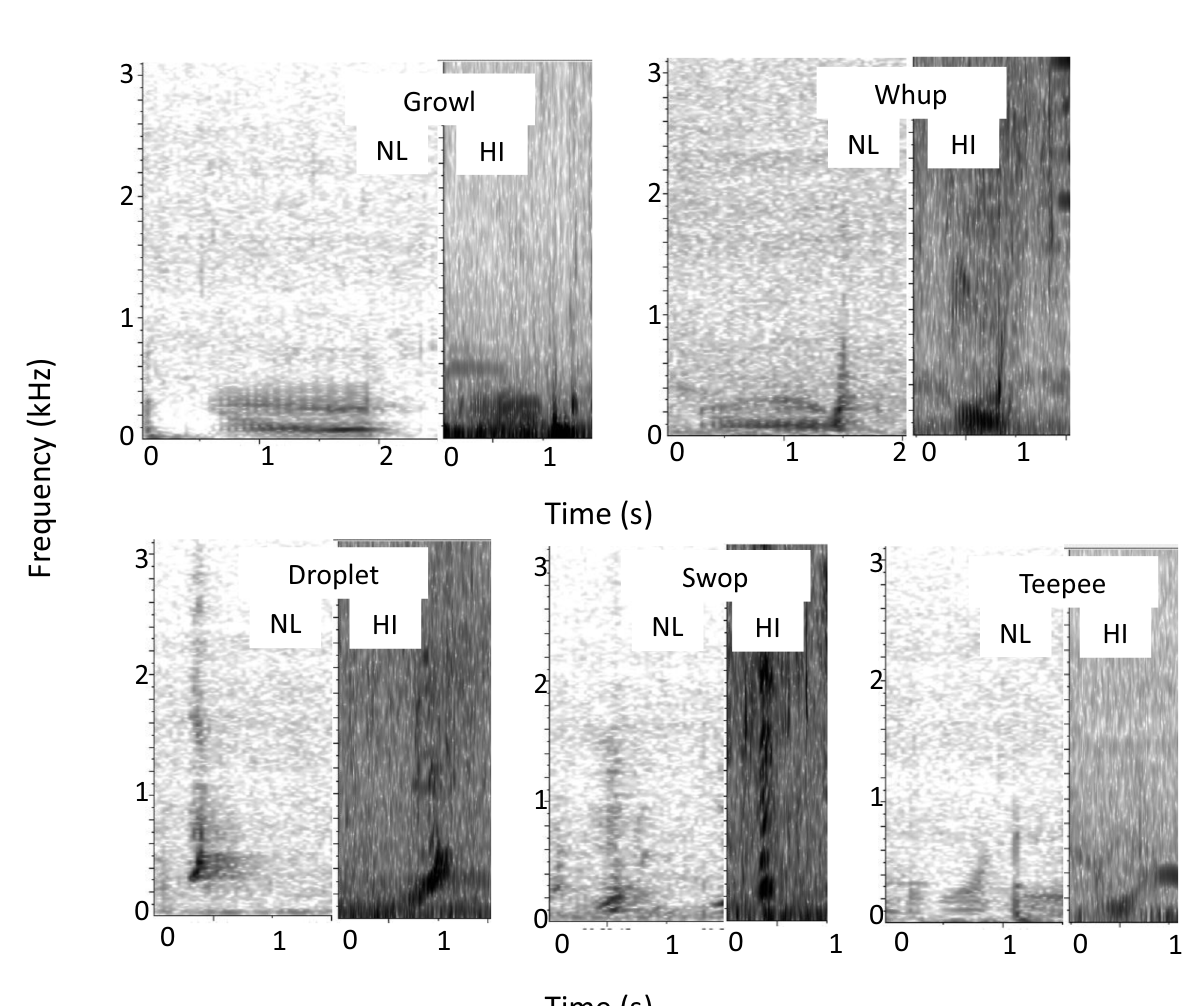
Figure 2. Spectrograms examples (Hann window, 8192 (NL) and 32,768 (HI) Discrete Fourier Transform, 2.93 Hz resolution, and 50% overlap) of each of the five call types from each population, NL Newfoundland during 2015, 2016, HI Hawaii during 1981, entropy were most positively associated (component loadings: 0.65 and 0.51). As such, higher PC2 values refer to calls with a larger range in frequency and higher entropy. Three variables were positively associated with PC3 (amplitude modulation, frequency modulation, and number of inflection points; component loadings: 0.70–0.73), thus higher PC3 values refer to calls with more variation in frequency and amplitude. For all calls except droplets, the HI calls showed a greater degree of within-call type variation in both PC1 and PC2, but the variation overlapped between populations within each AV classified call type (Figs. 3, S1). The NL calls tended to be lower frequency and longer duration, relative to HI calls (i.e. lower PC1 values), with the exception of droplets